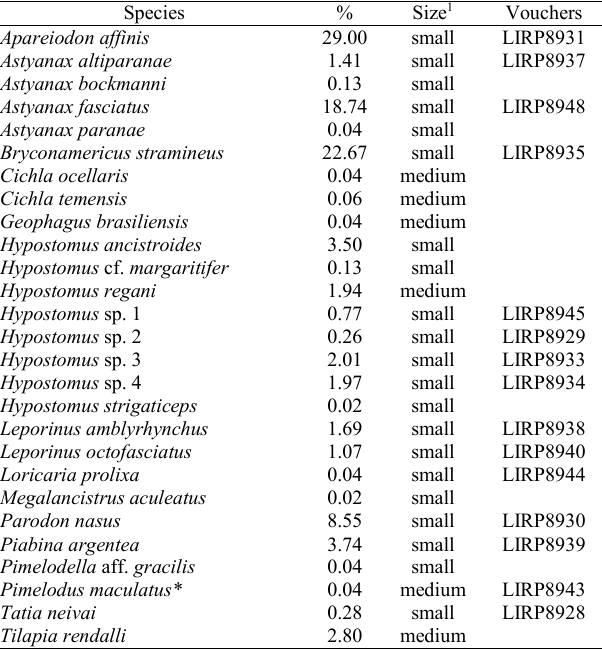
Table 2 . Index of Frequency (%) and size for the species caught in the fish ladder in the samplings. Source: 1. Reis et al . (2003); * long distance migratory species.